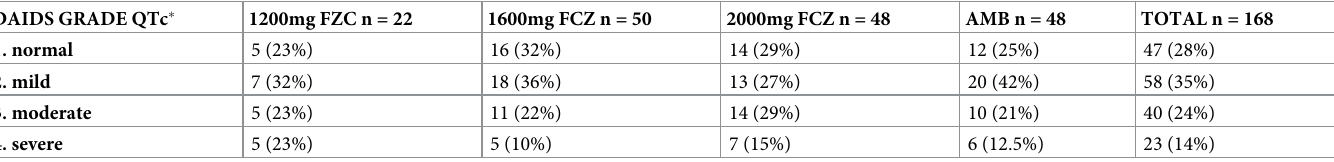
Table 8. Maximum DAIDS QTc � Grade of Visit or change from baseline.